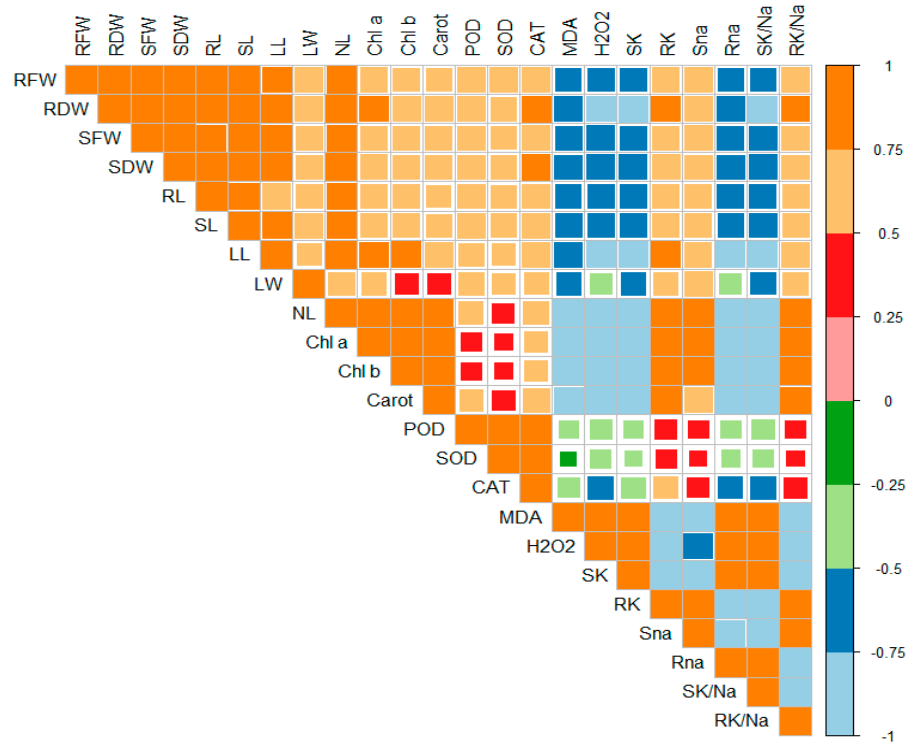
Figure 7. Correlation matrix represents the relationships between various parameters under study.